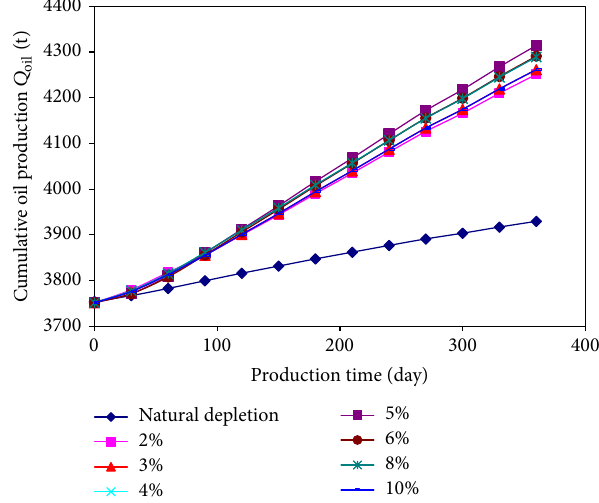
Figure 11: The variation of the cumulative oil production with injected solution at different reagent solution mole